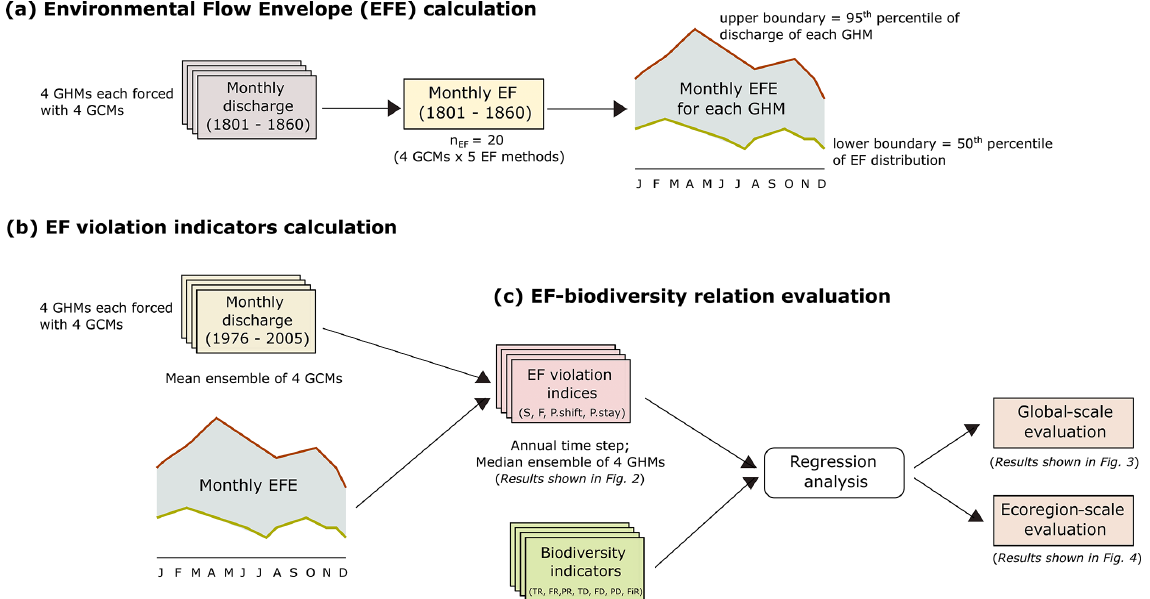
Figure 1. Outline of the methodologies used for (a, b) EF violation indicator calculation and (c) EF–biodiversity relationship